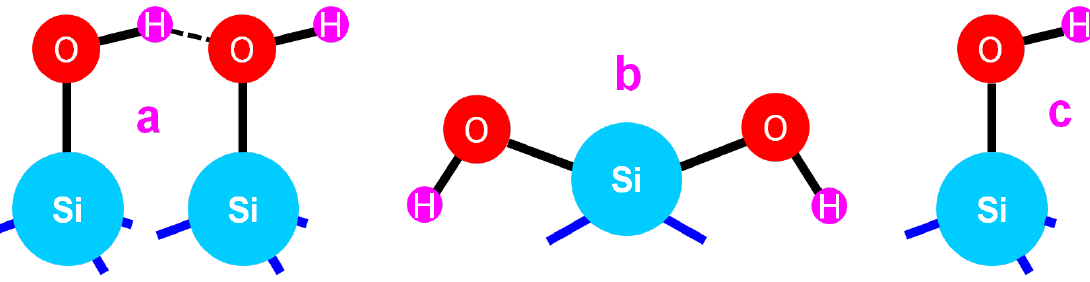
Figure 4. Different sorts of silanols: ( a ) vicinal silanols, ( b ) geminal silanols, and ( c ) isolated silanols 181